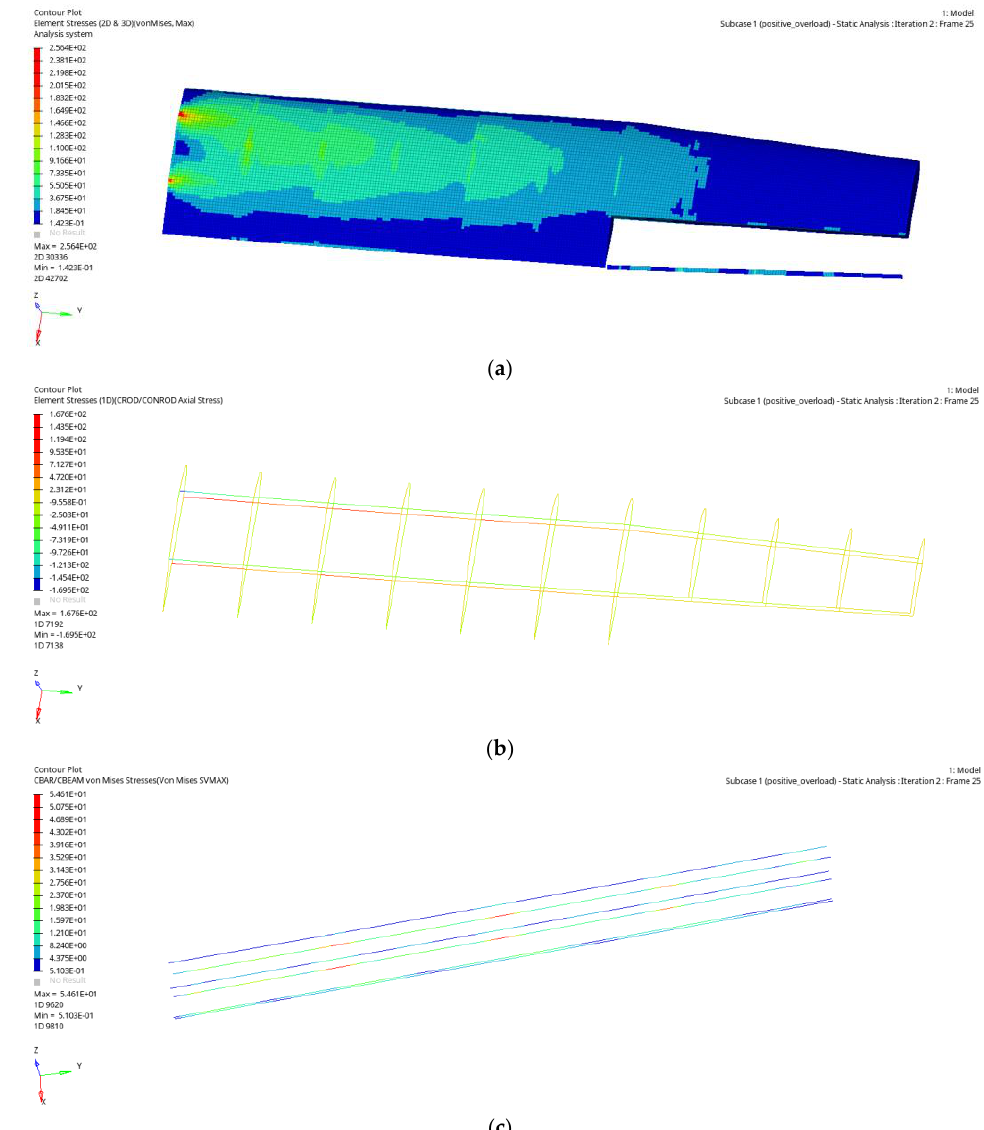
Figure 21. Stress of aluminum wing structure (condition D): ( a ) shell element; ( b ) rod element; ( c ) beam element.